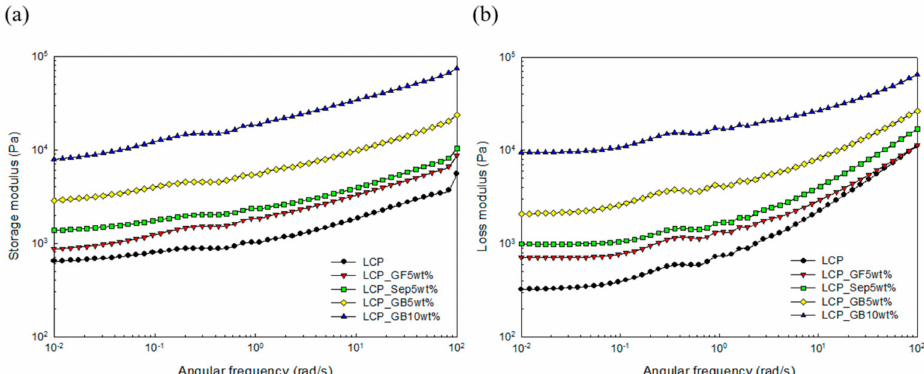
Figure 3. Modulus of the composites as a function of the angular frequency: ( a ) Storage modulus (G’) and ( b ) loss modulus (G”).